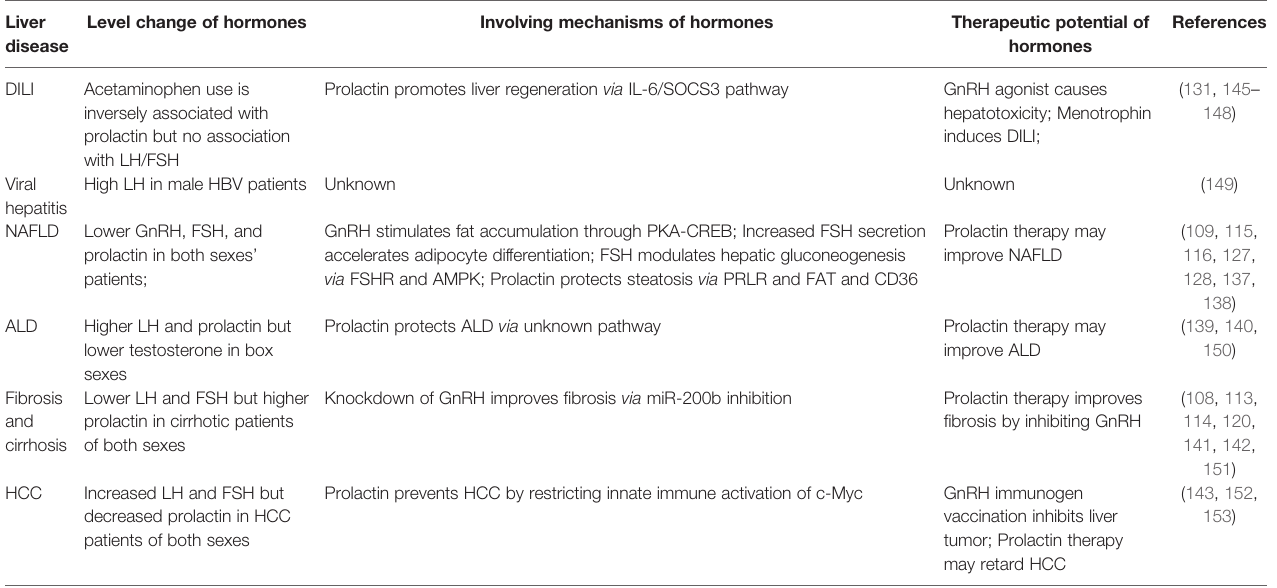
TABLE 2 | The involving roles and therapeutic potentials of sex-related hormones in liver